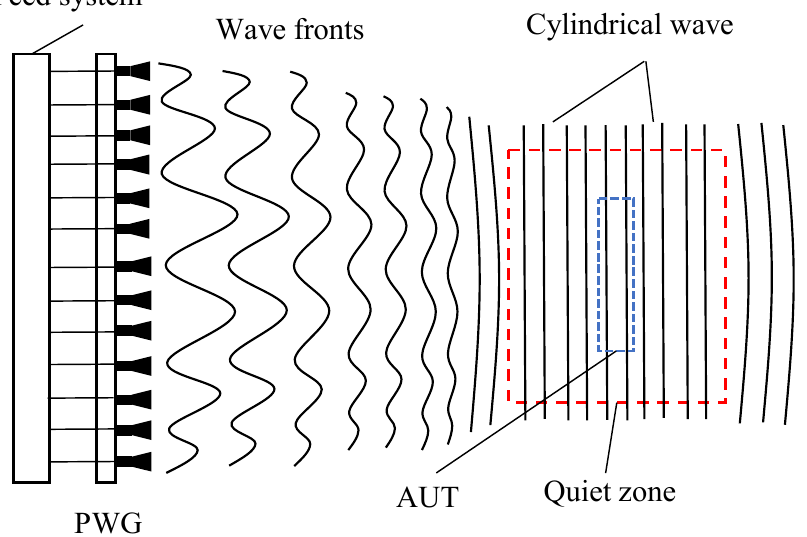
Figure 1. Schematic diagram of a PWG.